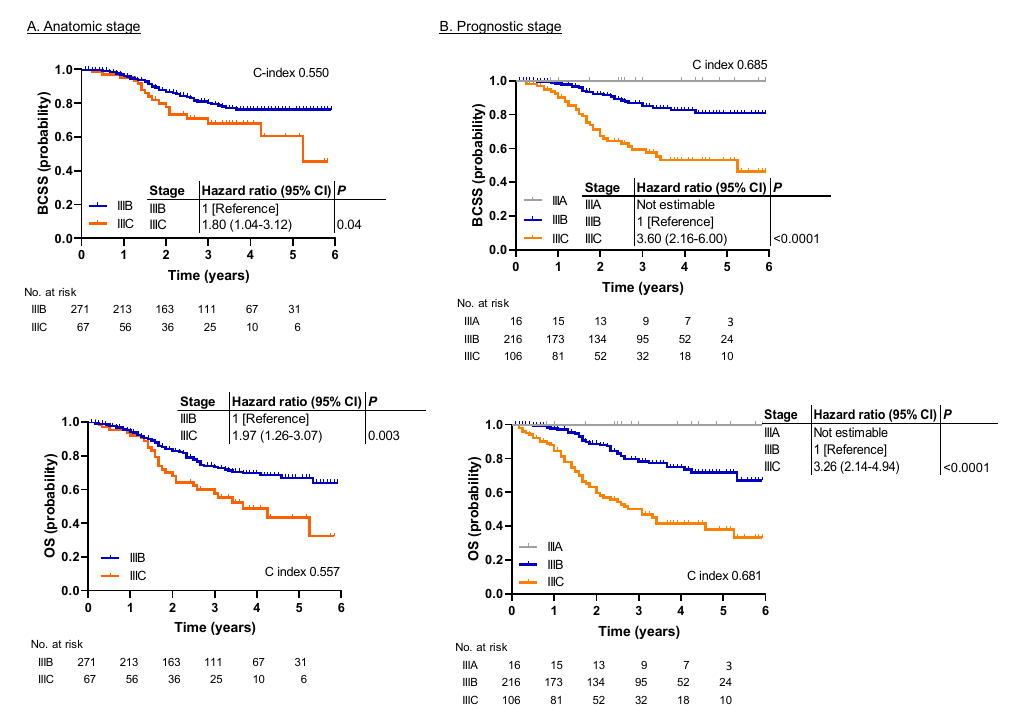
Figure 2. Kaplan–Meier survival plots demonstrating the association between the anatomic / prognostic staging systems and survival outcomes in patients registered in the national Surveillance, Epidemiology, and End Results (SEER) database (SEER cohort). ( A ) Survival analysis by anatomic stage for BCSS and OS. Statistically significant di ff erences were observed in BCSS and OS. ( B ) Survival analysis by prognostic stage for BCSS and OS. Significant di ff erences between IIIB and IIIC were more prominent with prognostic stage than with anatomic stage. BCSS, breast cancer-specific survival; HR, hazard ratio; OS, overall survival.